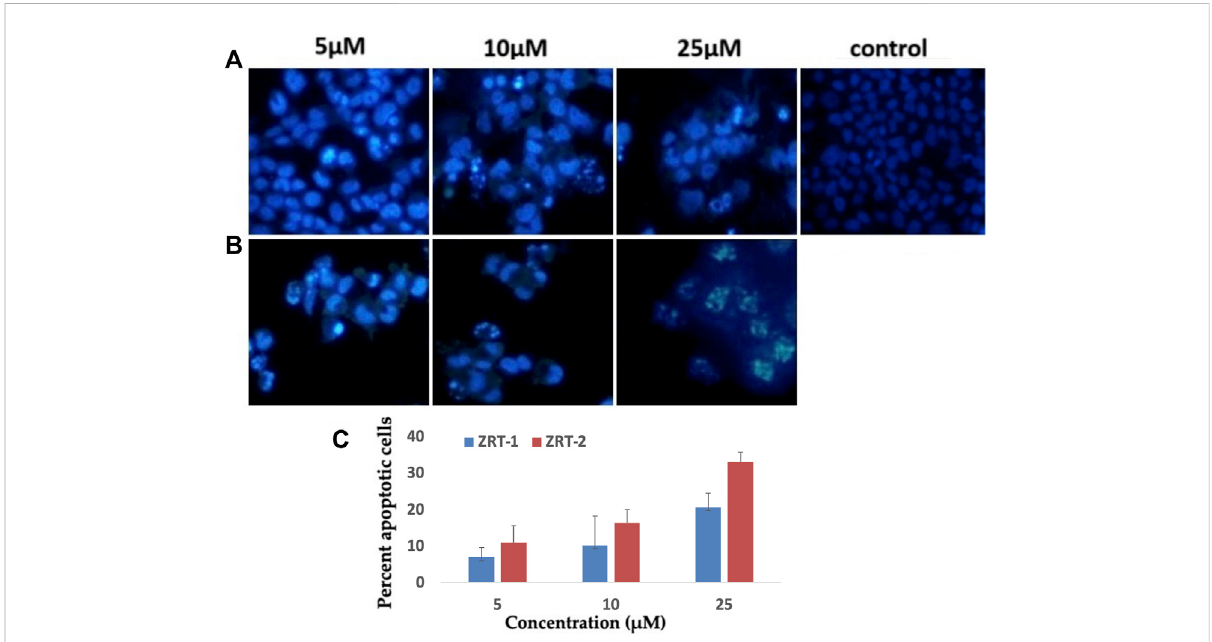
FIGURE 8 (A,B) : Human epidermoid carcinoma A431 cell lines were treated with control, 5 μ M, 10 μ M and 25 μ M concentration of zinc oxide nano- particles, ZRT-1 and ZRT-2, respectively and stained with DAPI (C) Representative graphs showing the numerical data of the percent apoptotic cells against the concentration of zinc oxide nano-particles, ZRT-1 and ZRT-2. Values are expressed as mean ± SEM of at least three independent experiments, * p < 0.05 as compared with their respective